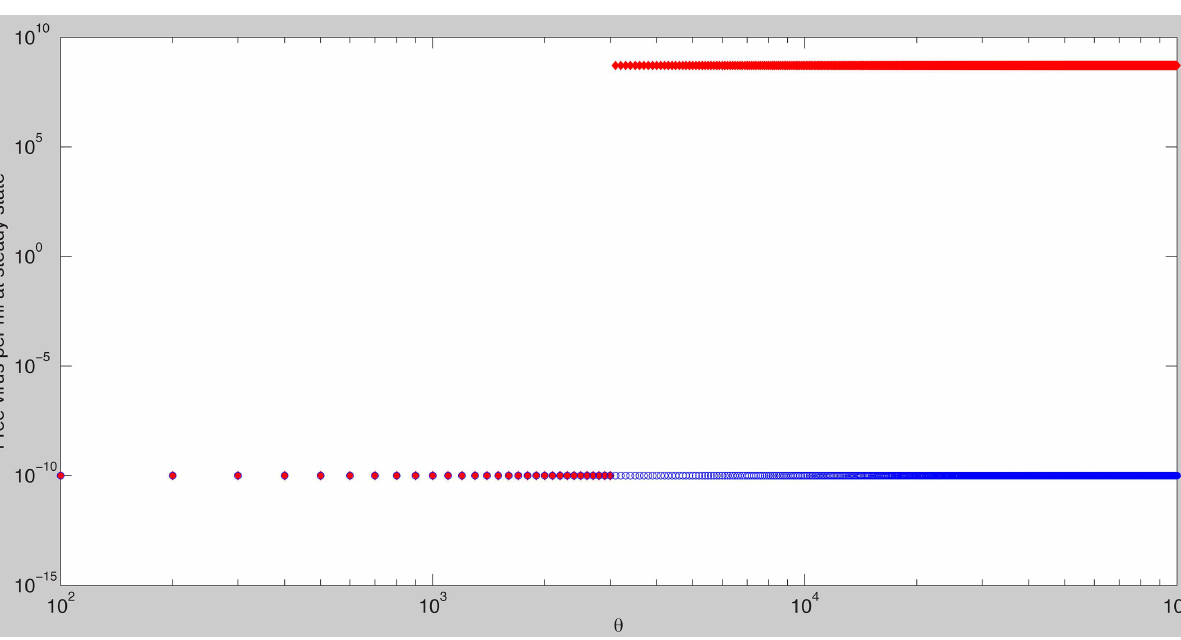
Figure 4. Stable steady state solutions for V as given by model (7) as a function of h . The other parameters are as in Tables 1 and 2 (median values). Notice bistability between the chronic and the cleared infection steady states occurs when h w h c ~ 3 : 1 | 10 3 . The cleared infection steady state is reached for all h when A 0 ~ 10 8 molecules per ml.